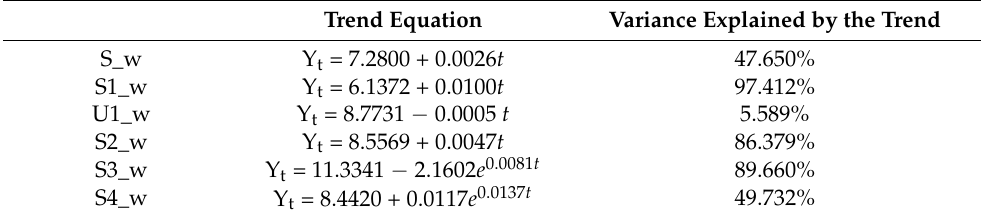
Figure 4. The weekly series and subseries. and the models are significant at a 0.05 significance level (based on the t-test and the F-test). The trend determined for the series and subseries is the best fit for the data series, selected from a set of deterministic models (linear, exponential, polynomial of the second and third-order, logarithmic, and power functions). Table 12. The equations of the trend for the weekly series and subseries. Trend Equation Variance Explained by the Trend S_w Y t = 7.2800 + 0.0026